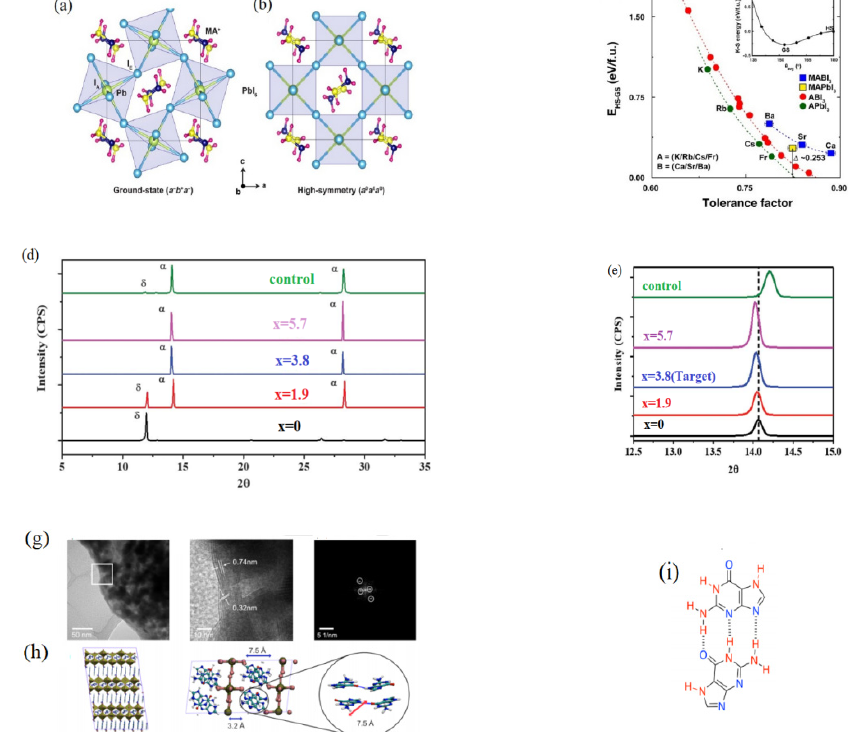
Figure 8. ( a ) The ground state of o-MAPbI 3 ; ( b ) High symmetry structures of o-MAPbI 3 ; ( c ) Corresponding the energy of o-ABI 3 (red), o-APbI 3 (green), o-MABI 3 (blue), and o-MAPbI 3 (yellow). The difference of t can be seen according to the horizontal error bars of the o-MABI 3 hybrid structures. (Reprinted with permission from Ref. [100]. Copyright 2016 ACS Publications). XRD pat- terns of FAPbI 3 :xMDACl 2 perovskite. ( d ) The perovskite was exposed to 80% humidity for 24 h and annealed at 150 ◦ C for 10 min. ( e ) The perovskite synthesized with different x values (x = 0, 1.9, 3.8, and 5.7 mol%) and (001) orientation peaks was magnified. Reprinted with permission from Ref. [102]. Copyright 2019 Science. ( f ) 14 N NMR spectra of α -FAPbI 3 (top) and G-containing α -FAPbI 3 (bot- tom). ( g ) A lower magnification TEM image and high-resolution TEM image of G 2 FA n − 1 Pb n PbI 3n+1 (n = 20) perovskite; ( h ) The structure of G 2 FAPb 2 I 7 optimized by DFT. ( i ) The structure of H bond (HB) dimer, including H bond donating (red) and accepting sites (blue). Reprinted with permission from Ref. [103]. Copyright by 2019 Angewandte Chemie International